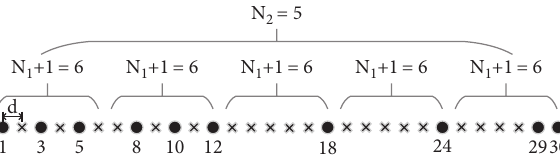
Figure 2: The structure of two-level super nested